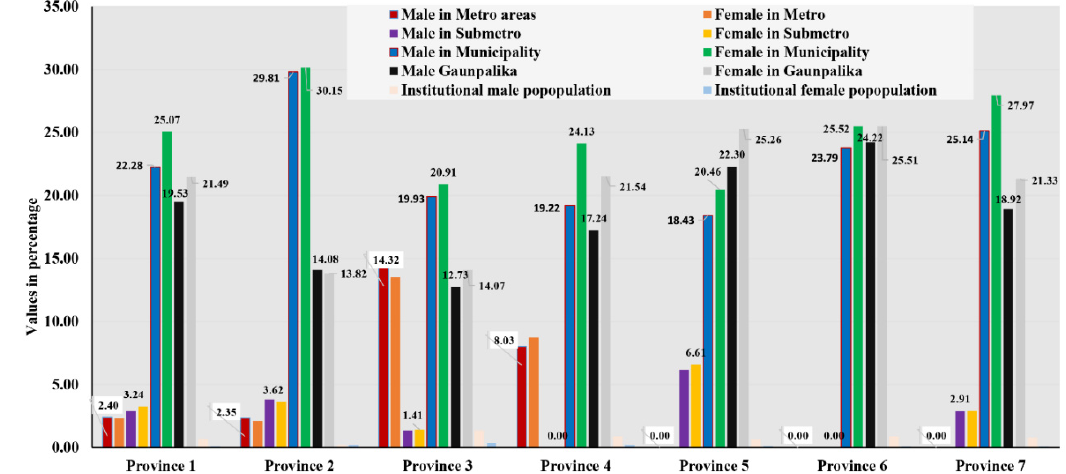
Figure 10. Population distribution in various provinces [43,59]. Figure 11. Population distribution in various provinces